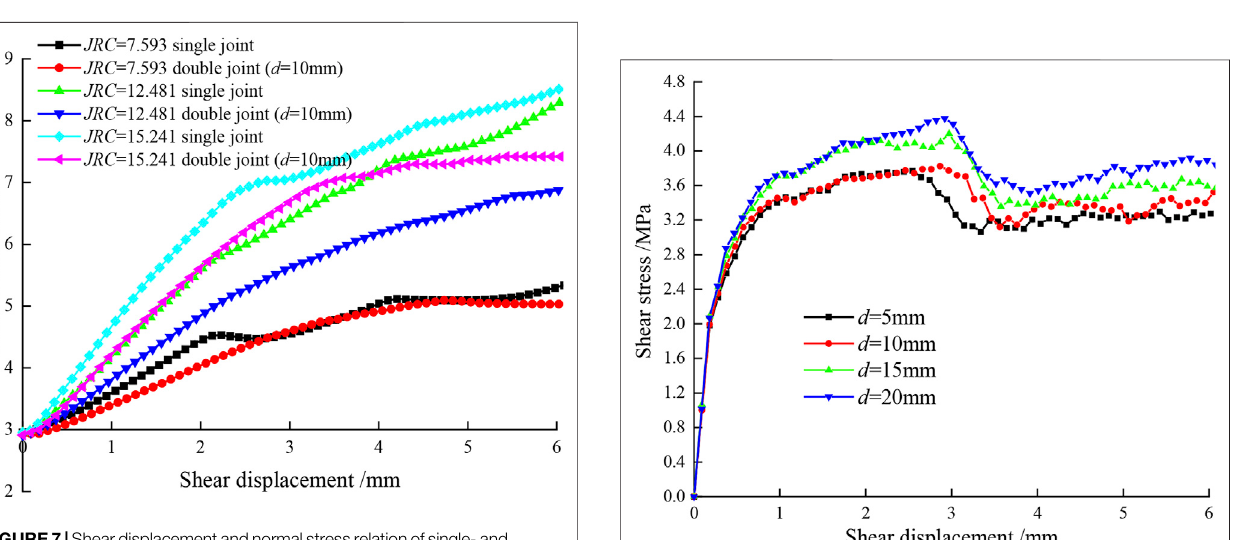
FIGURE7| Sheardisplacementandnormalstressrelationofsingle-and double-joint specimens.